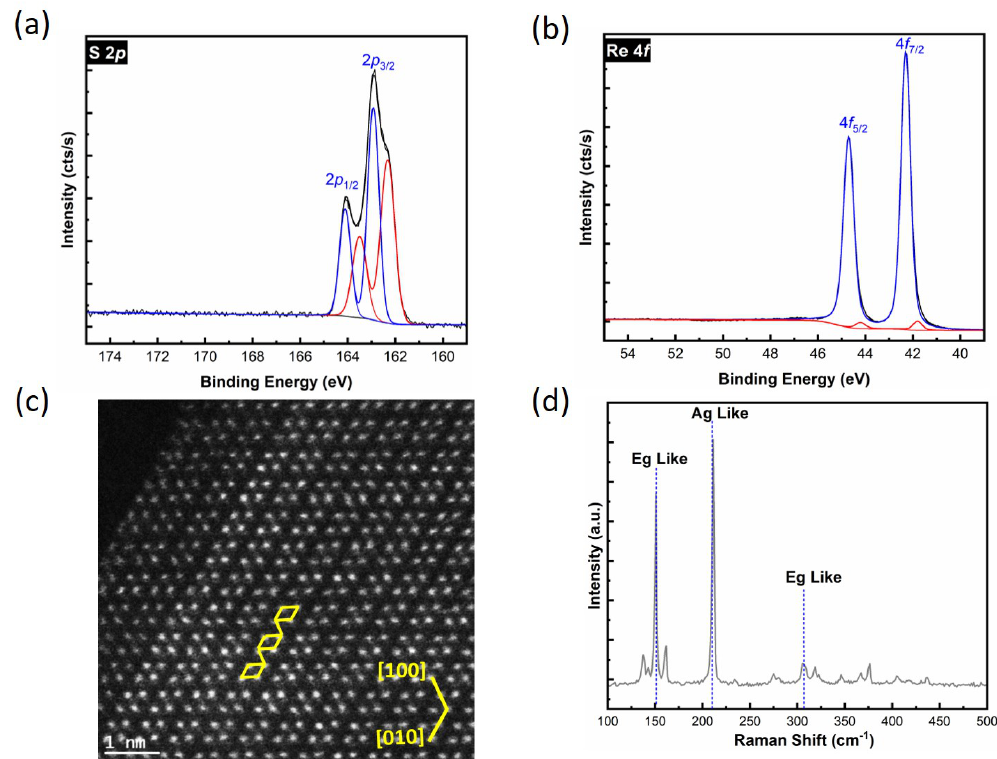
Figure 1. ( a ) S 2 p and ( b ) Re 4 f X-ray photoelectron spectroscopy (XPS) core level spectra obtained on a freshly exfoliated ReS 2 surface. The additional component in the lower binding energy is shown in red for both spectra. ( c ) High-angle annular dark field (HAADF) presents only Re atoms and ( d ) Raman spectrum of exfoliated ReS 2